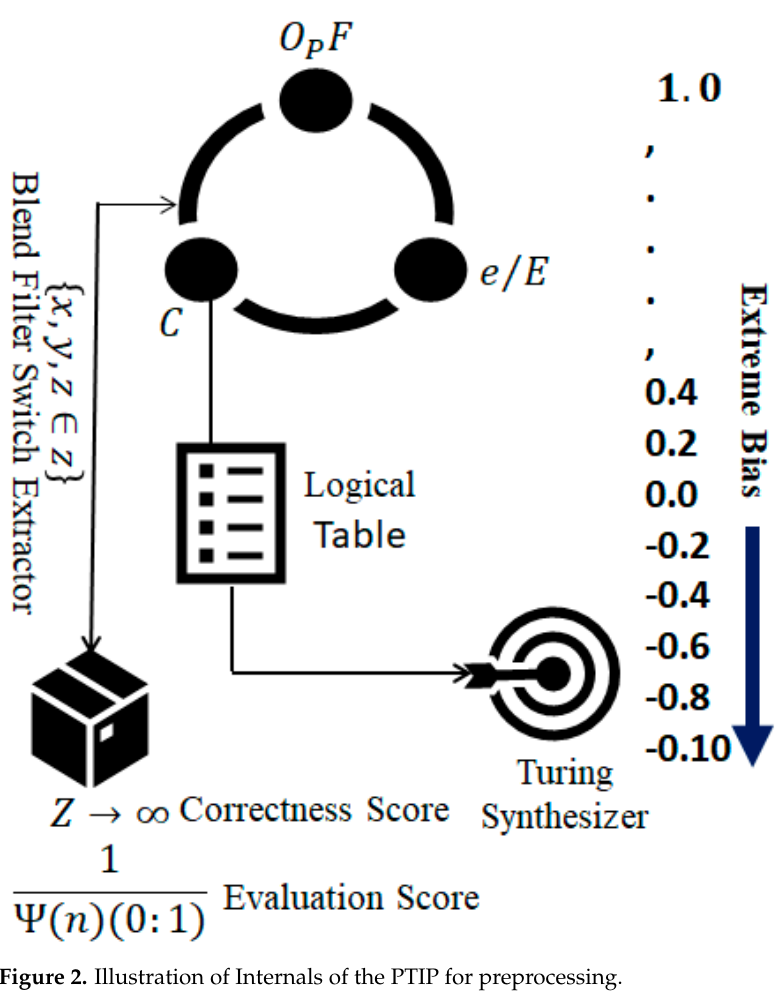
Figure 2. Illustration of Internals of the PTIP for preprocessing